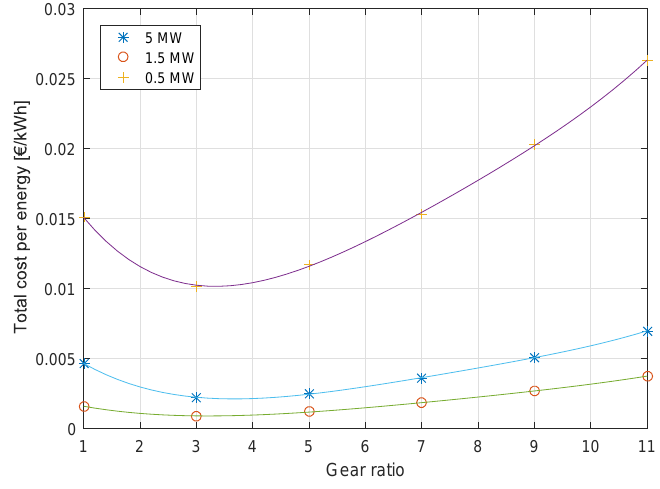
Figure 14. TST total estimated cost per